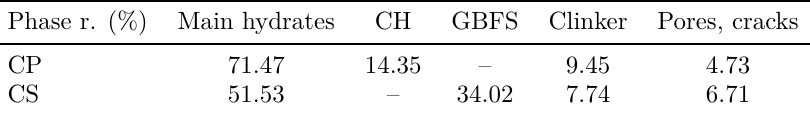
Table 1. Phase representation calculated from SEM-BSE images.